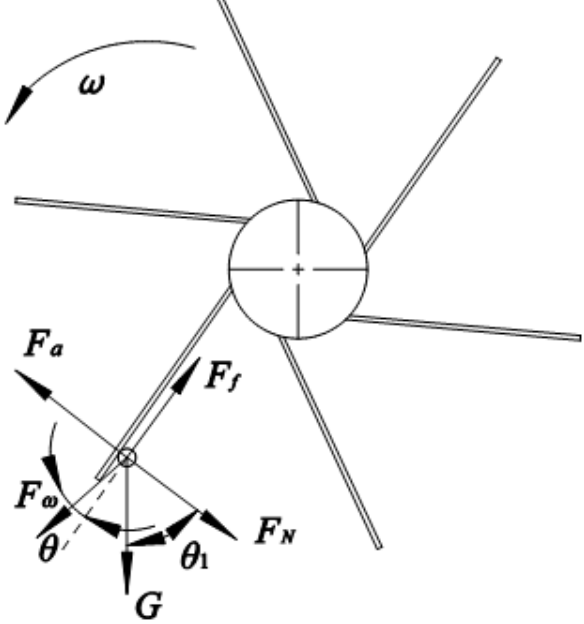
Figure 4. Schematic diagram of the force of the blade on the residual film.